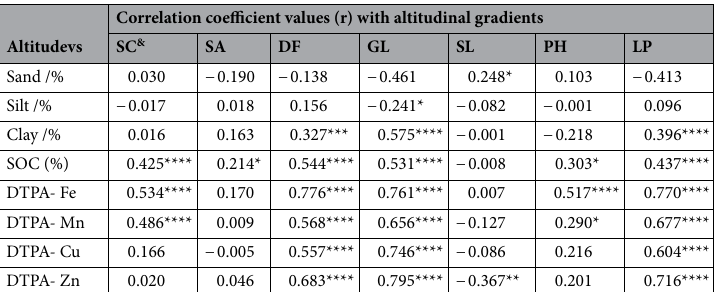
Table 6. Response of land use systems to altitudinal gradients measured in terms of correlation coefficients (r) on particle size distribution (%), SOC (%) and DTPA-extractable micronutrient contents (mg kg −1 ). Level of significance at P = 0.05 (*), 0.01 (**), 0.005 (***) and 0.0005 (****); SC & : Shifting cultivation, SA: